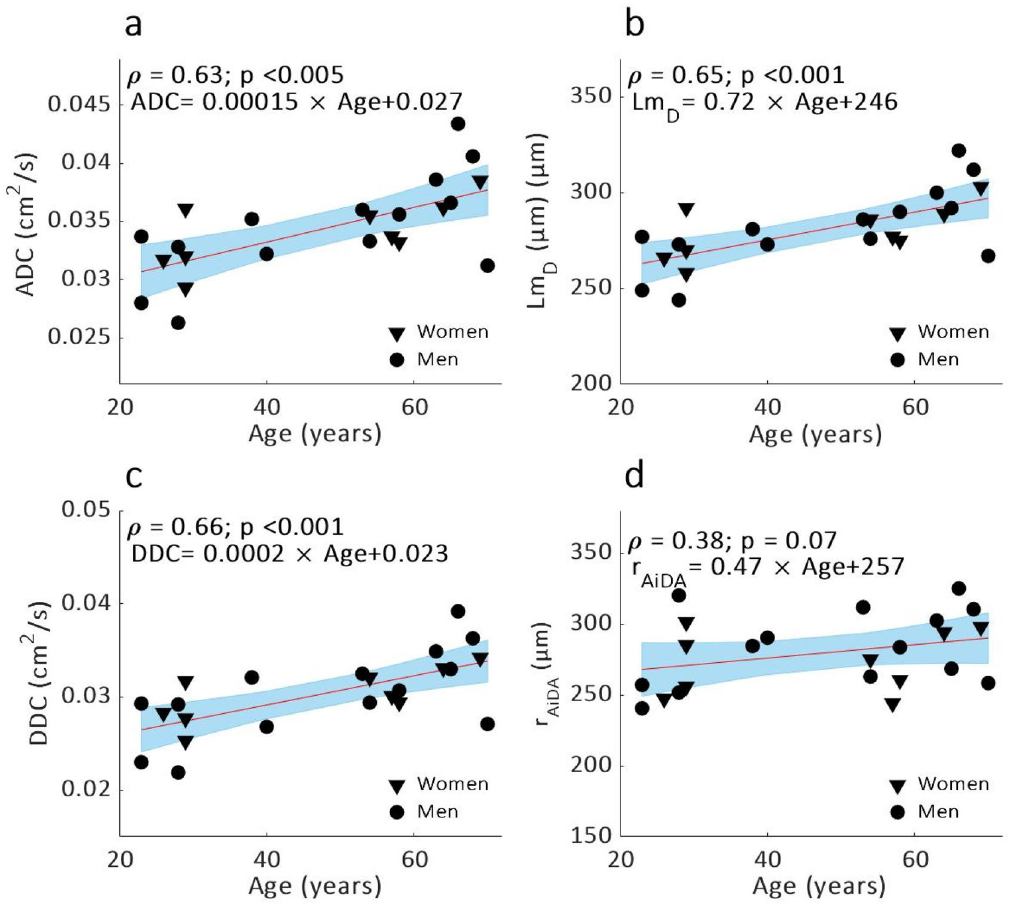
D , ( c ) DDC and ( d ) r AiDA as a function of